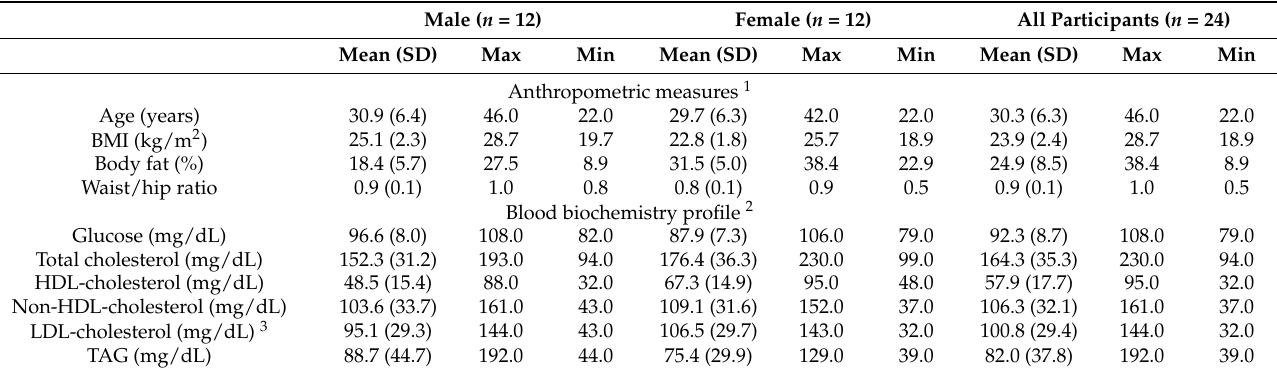
Table 1. Anthropometric characteristics and fasting blood biochemistry from the twenty-four participants, at the time of recruitment (mean values and standard